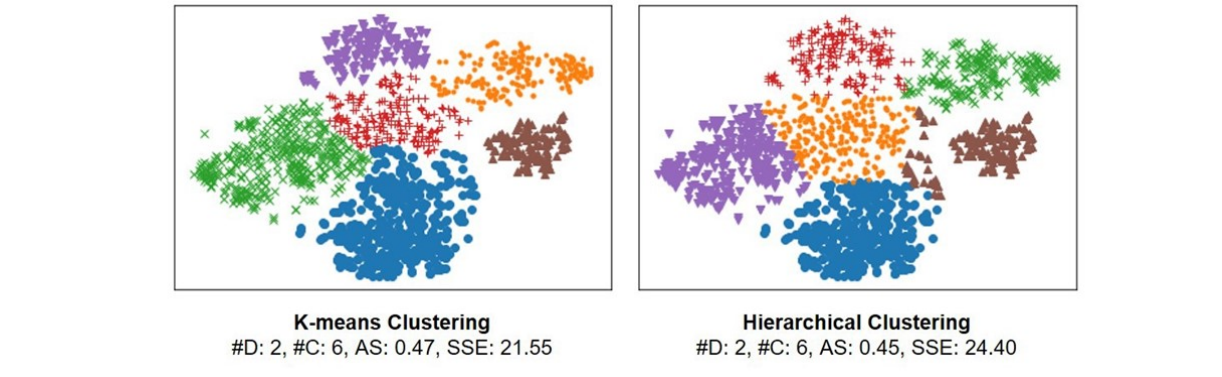
Figure 8. Clusters of 8-day chunk images based on sequential sleep/activity patterns. D: dimensions; C: clusters; AS: average silhouettes; SSE: sum of squared